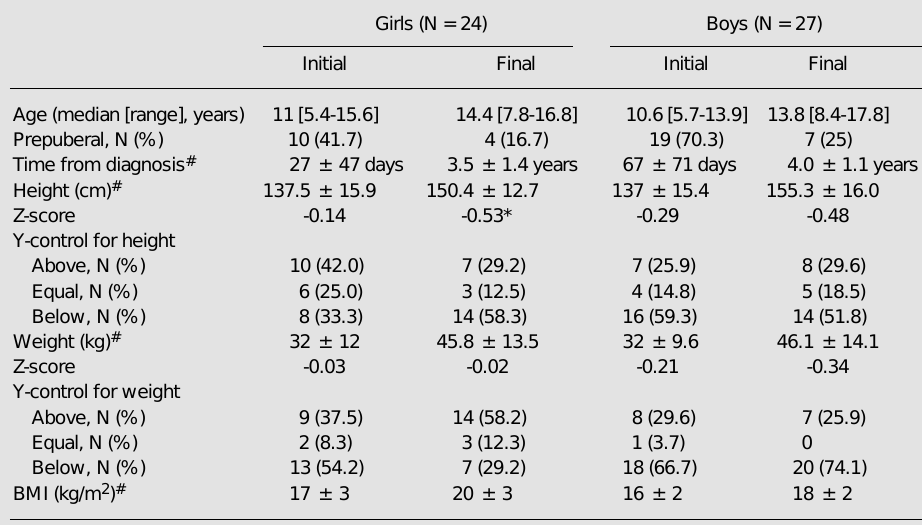
Table 2. Clinical characteristics of children with type 1 diabetes mellitus at diagnosis and at the end of